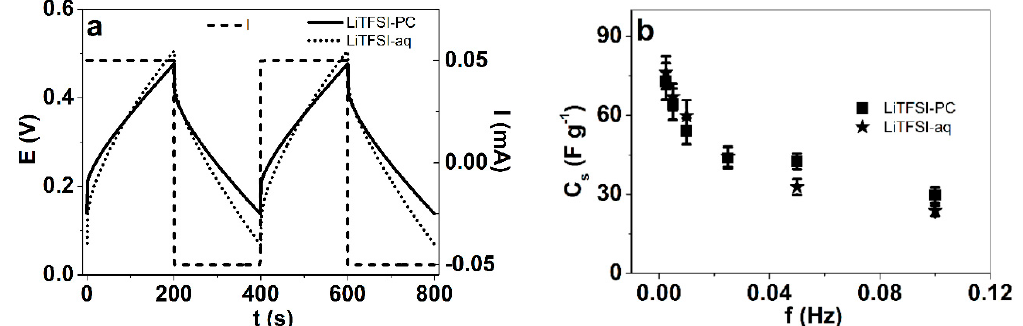
Figure 6. ( a ) Chronopotentiogram of PPyPIL films at 0.0025 Hz ( ± 0.05 mA, 2nd and 3rd cycles, dashed) in LiTFSI-PC (solid line) and LiTFSI-aq (dotted) at constant charge of 10 mC. ( b ) The specific capacitance C s was calculated using Equation (3) of the PPyPIL films in LiTFSI-PC ( ■ ) and LiTFSI-aq ( ★ ) against the applied frequency.